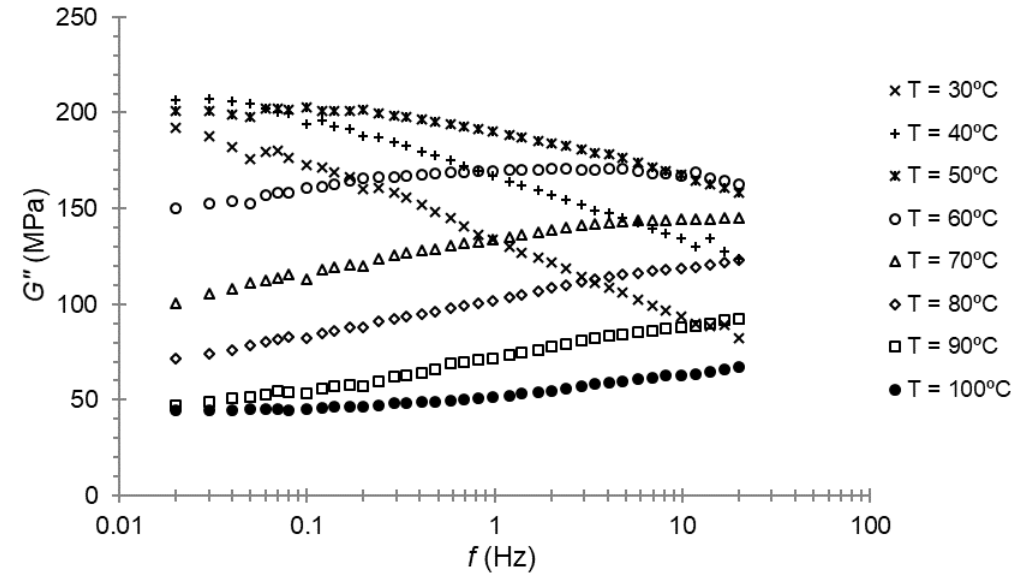
Figure 6. Loss modulus – frequency plot for